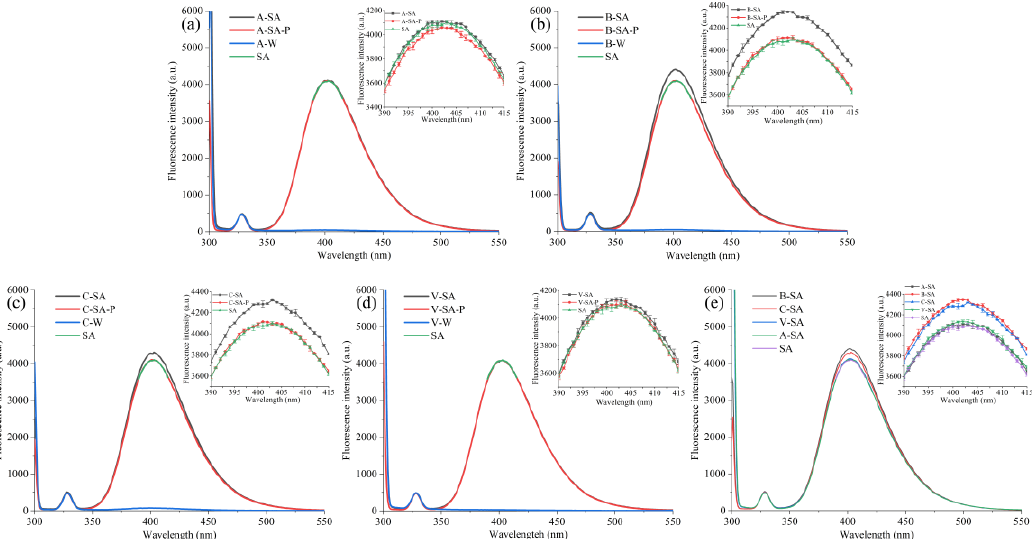
Figure 6. Fluorescence spectra of the four inclusions, corresponding physical mixture, four crystal types of starches, and SA. ( a ) the fluorescence spectra of A–SA, A–SA–P, A–W, and SA. ( b ) the fluorescence spectra of B–SA, B–SA–P, B–W, and SA. ( c ) the fluorescence spectra of C–SA, C–SA–P, C–W, and SA. ( d ) the fluorescence spectra of V–SA, V–SA–P, V–W, and SA. ( e ) the fluorescence spectra of A–SA, B–SA, C–SA, V–SA, and SA. All insets are local magnification of the fluorescence spectrum from 390 to 415 nm. A–W, B–W, C–W, and V–W represent the mixtures of the four crystal types of starches and water, respectively.